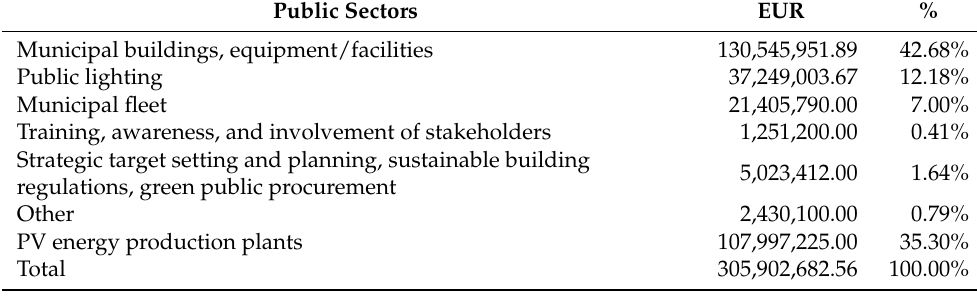
Table 10. SEAP resources for Public Administration.